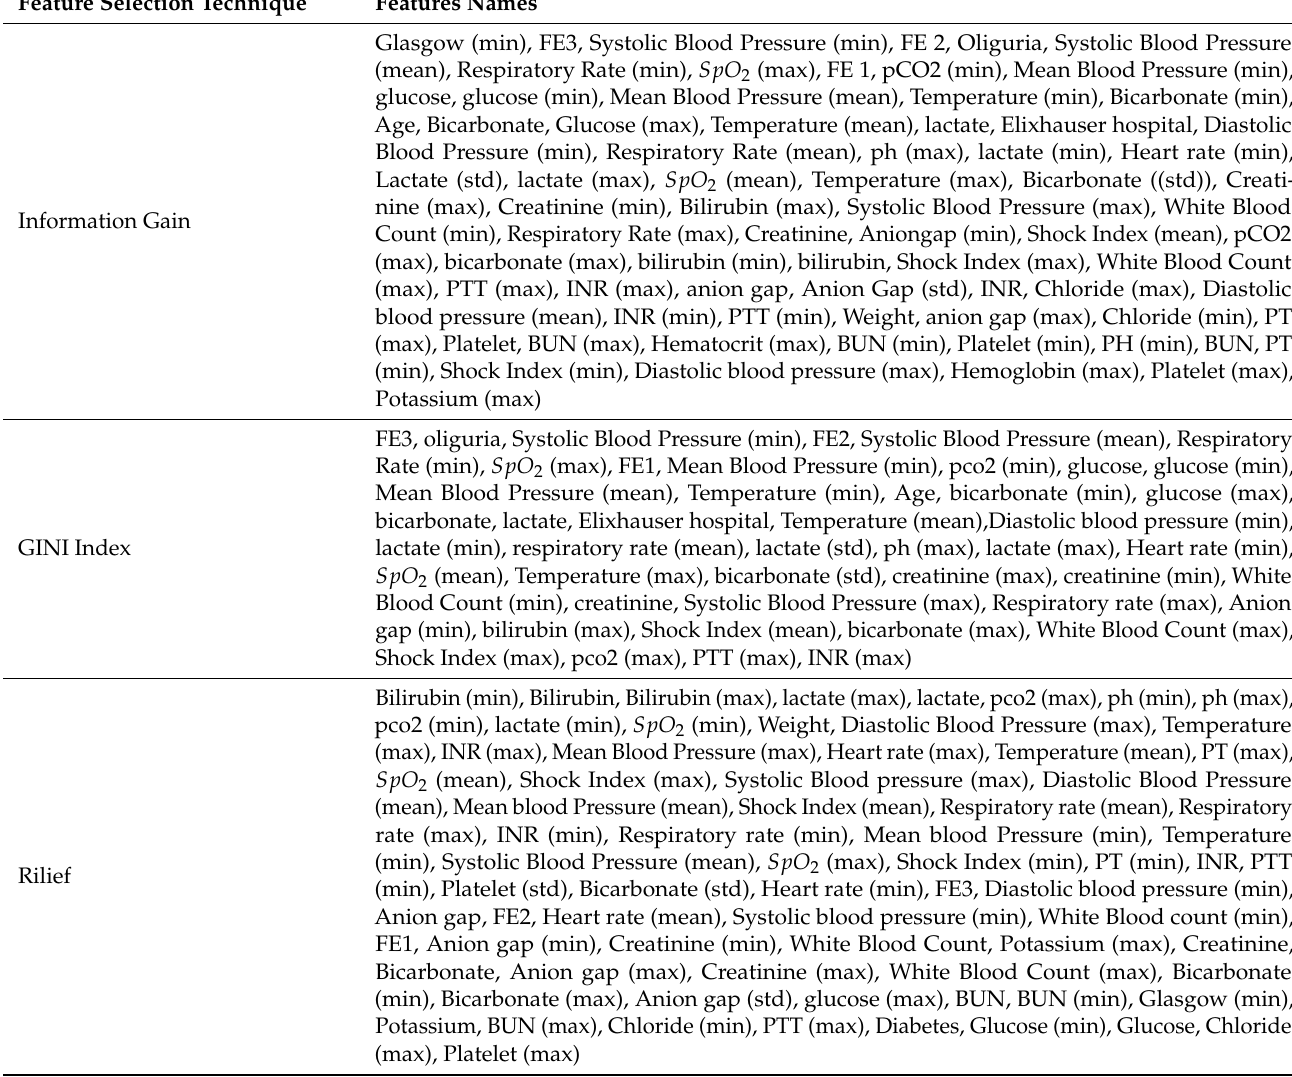
Table A1. Feature subset filtered using feature selection